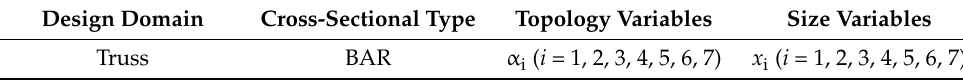
Table 1. Definition of design variables.